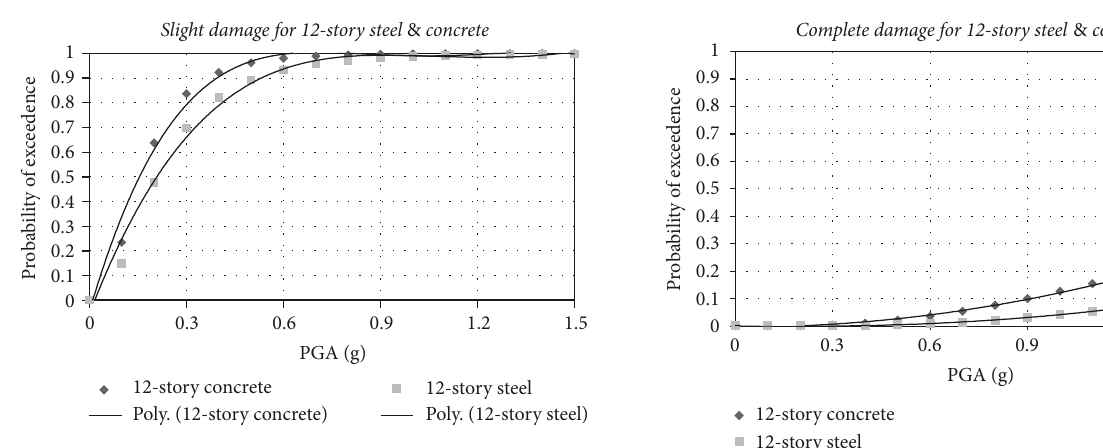
Figure 3: Comparison of the fragility of the 12-story steel and RC frame buildings for the slight damage state.